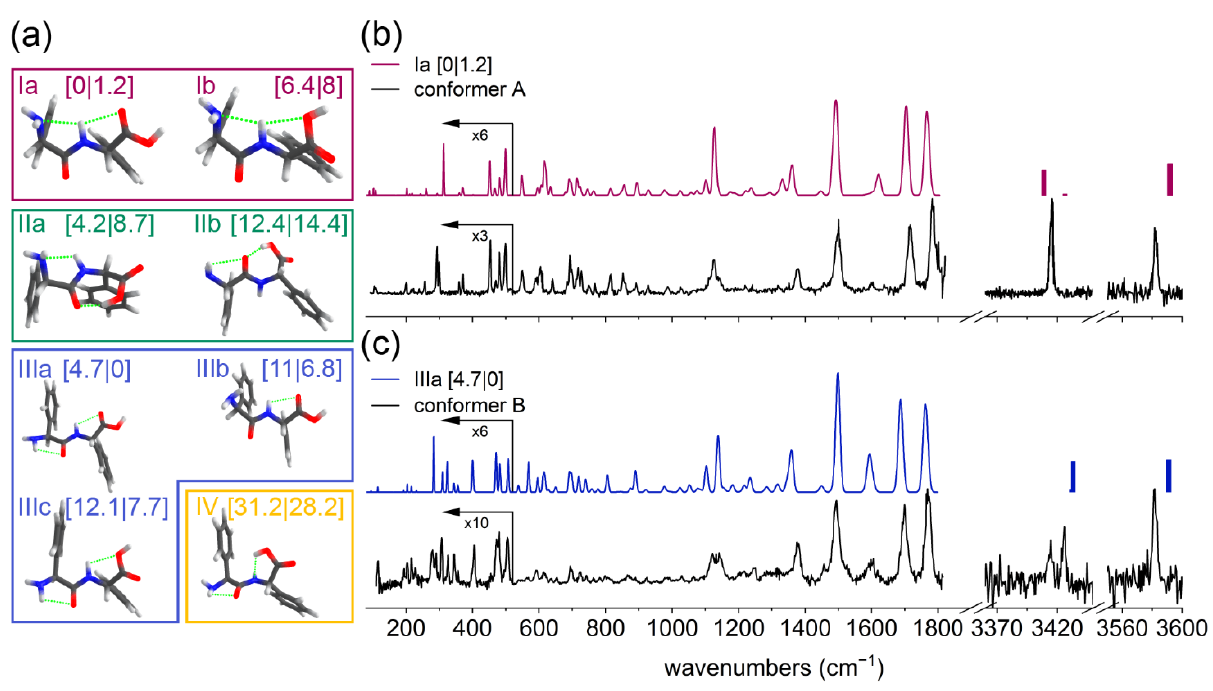
Figure 1. ( a ) The structural families of the PhgPhg monomer with their zero-point energies and Gibbs free energies at 300 K in kJ/mol shown between square brackets; ( b ) experimental IR spectrum of conformer A of the monomer (black) and calculated (pink) IR spectrum of the Ia structure; ( c ) experimental IR spectrum of conformer B of the monomer (black) and calculated (blue) IR spectrum of the IIIa structure. Calculated spectra are scaled by 0.976 (1800–100 cm − 1 ) and 0.956 (3370–3600 cm − 1 ). The region below 520 cm − 1 was multiplied for clarity, as indicated.